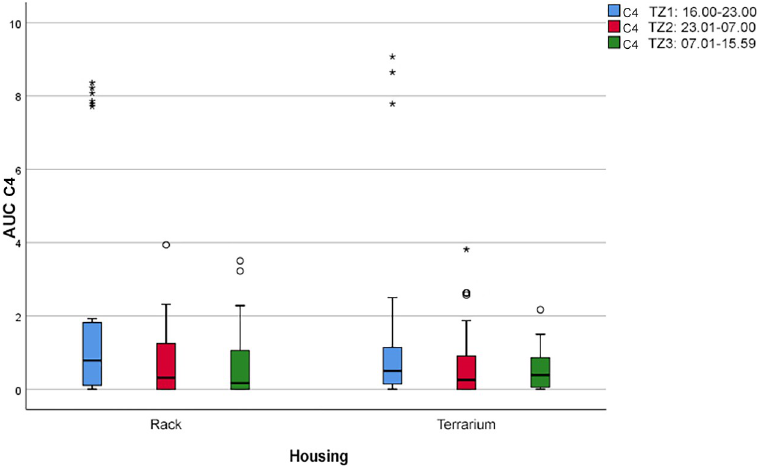
Fig 8. Boxplot with outlier (˚) and extreme outliers ( � ). Frequency of the comfort behavior “resting outside of the hiding place, coiled” (C4) during the three daytime periods (P) depending on the two housing systems ( p > 37.92).